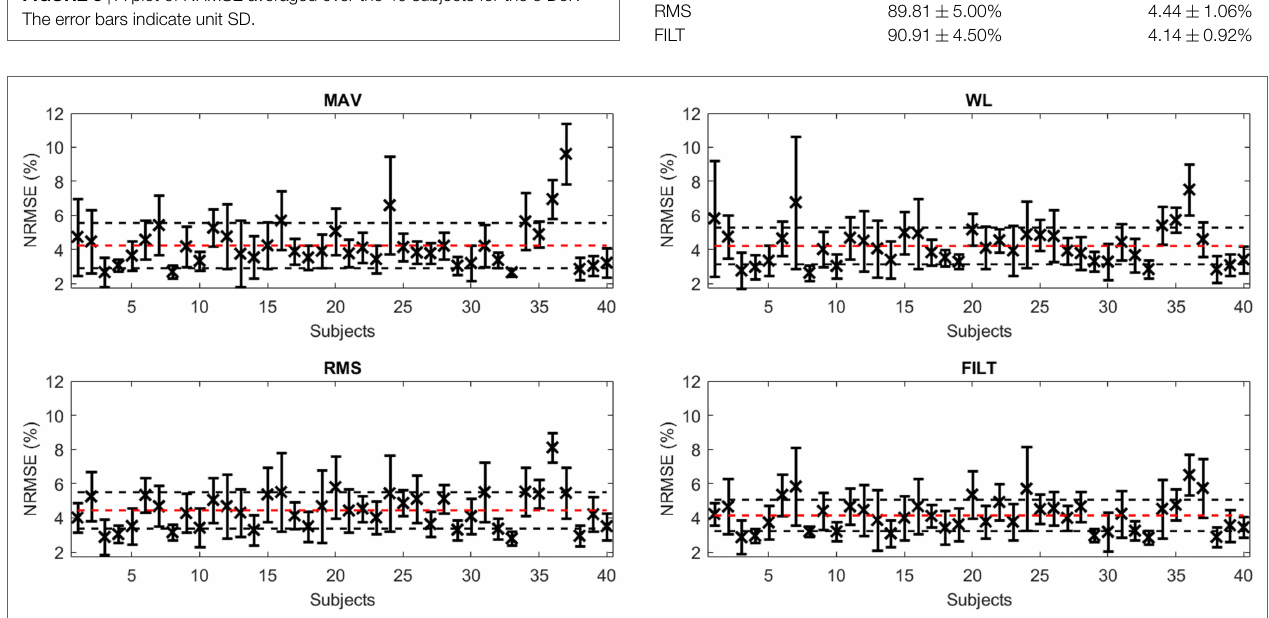
FIGURE 4 | A plot of average NRMSE for the model obtained for each subject for all FEs (x), along with (cid:6) 1 SD (black error bars). The red dashed line represents the mean NRMSE, while the horizontal black dashed lines represent (cid:6) 1 SD from this mean.